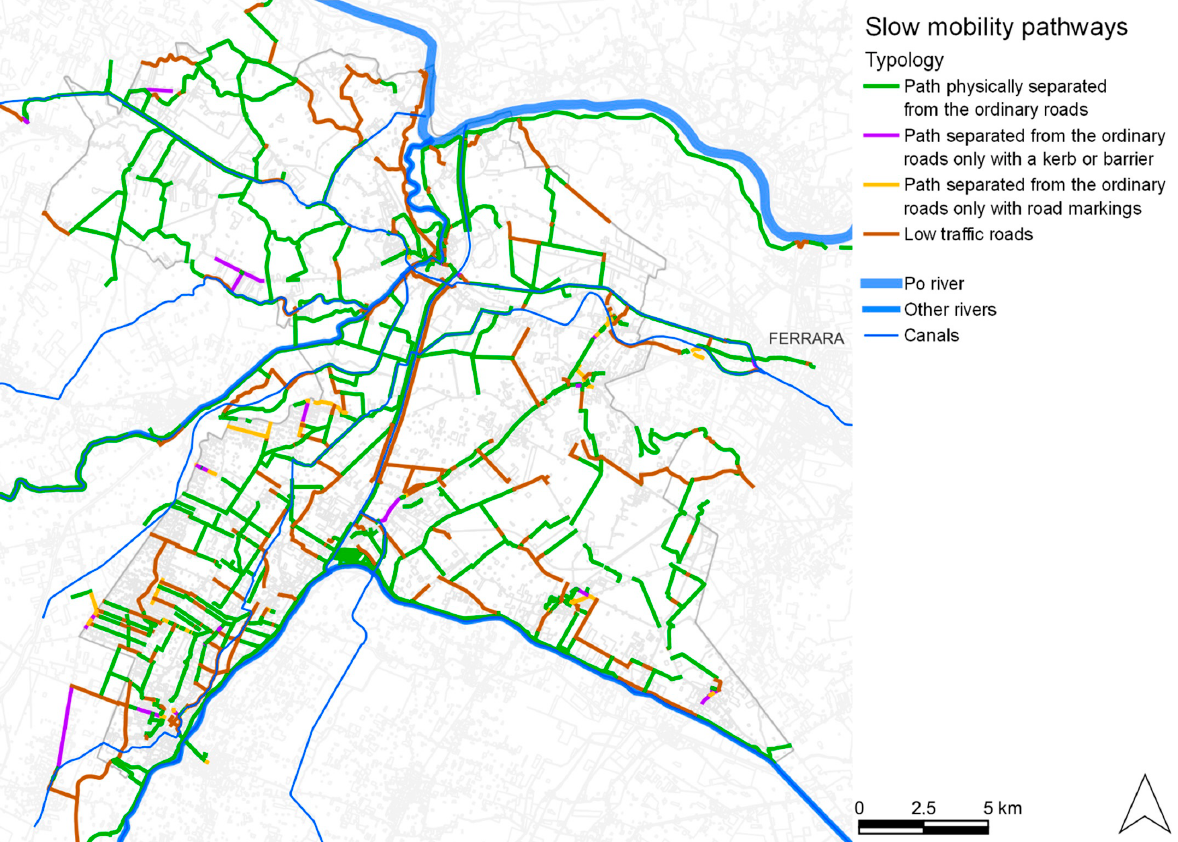
Figure 5. Existing paths surveyed in the study area.